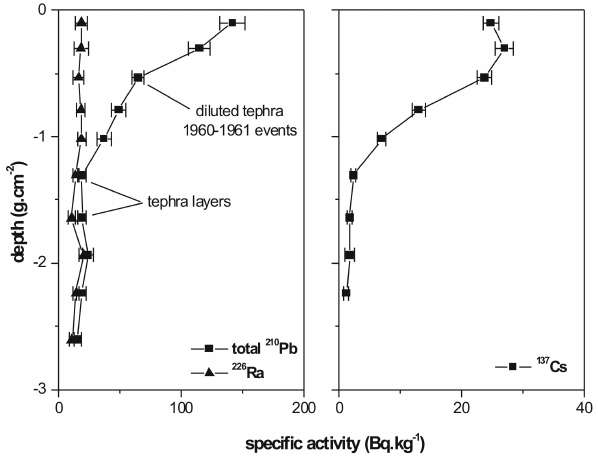
Fig. 2. Moreno Oeste sedimentary sequence. Specific activity pro- files of 137 Cs, 210 Pb, and 226 Ra (in secular equilibrium with sup- ported 210 Pb).